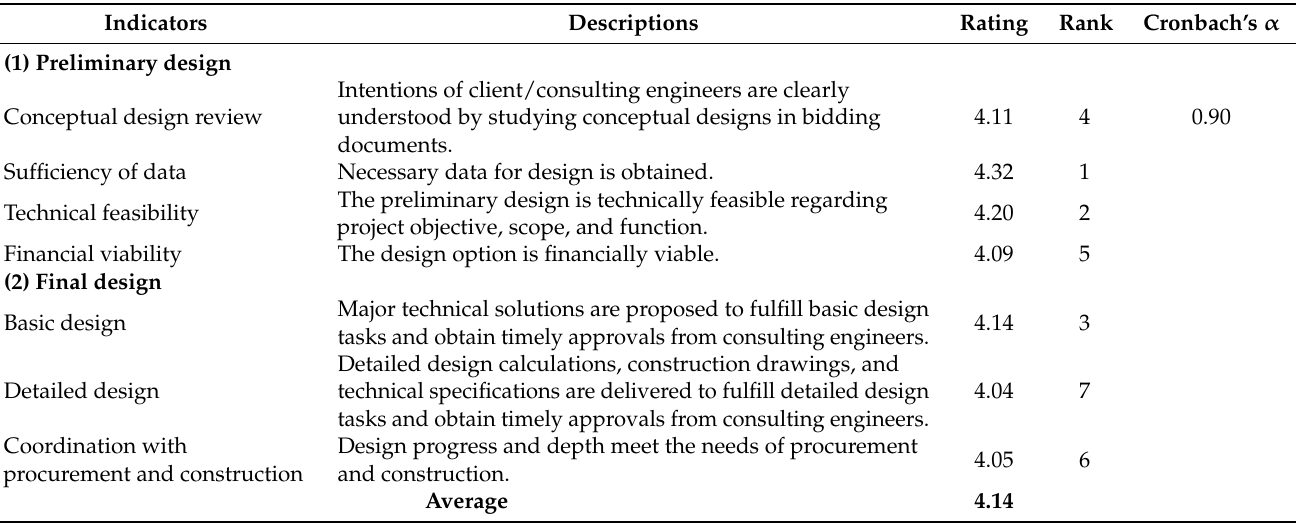
Table 4. Design capability of the EPC general